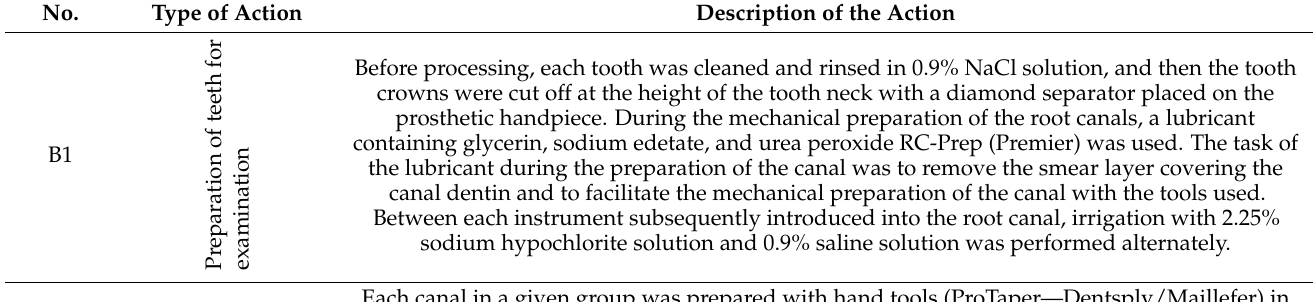
Table 2. Conditions and methods of teeth preparation for examination and methods of tooth root canal preparation. No. Type of